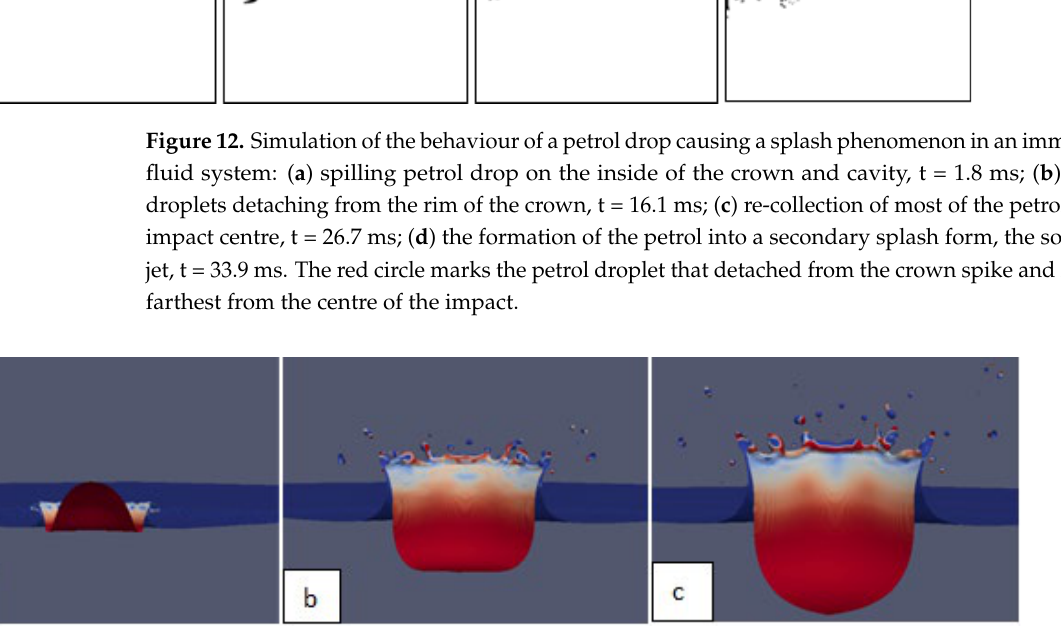
Figure 13. Visualisation of selected times of the 3D simulation of the multiphase splash phenome- non, depicted from the drop impact centre: ( a ) 0.7 ms; ( b ) 1.8 ms; ( c ) 3.2 ms time.